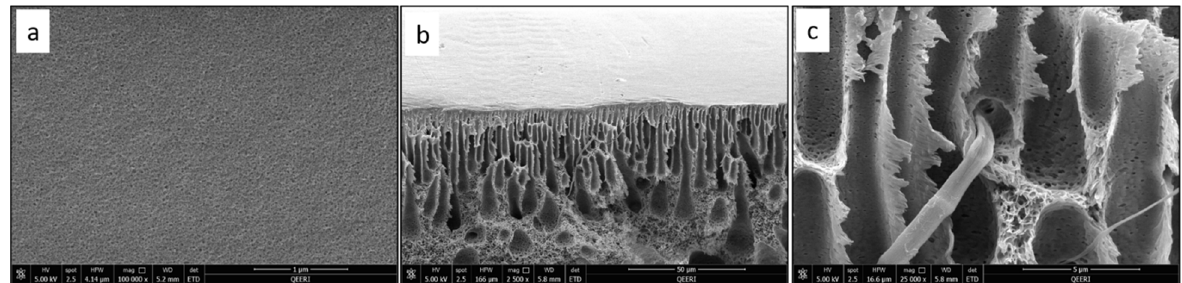
Figure 6. SEM images for PSF/0.2 wt.% CNF (M3) sample: ( a ) top surface, ( b ) cross-section, ( c ) enlarged top cross-section.